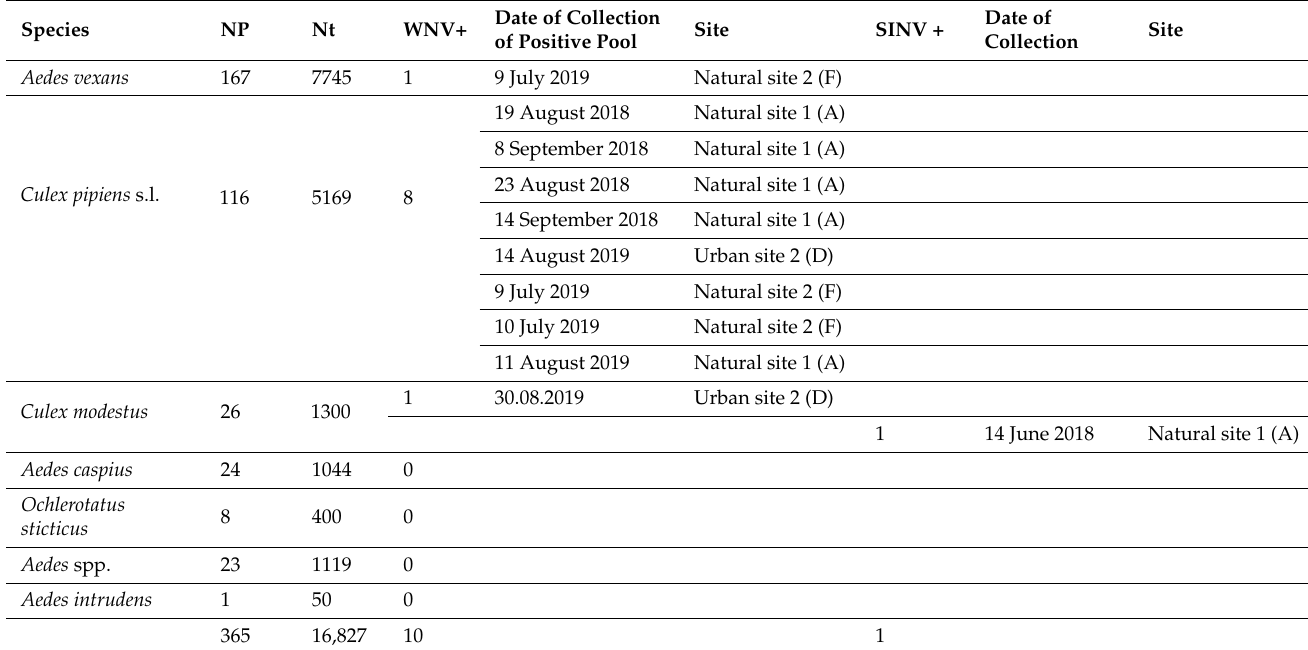
Figure 3. Mosquito screening results relative to the distribution of sampling sites in the two counties in eastern Romania. Purple circles represent urban sites, green circles represent the natural sites and the orange circle indicates the peri–urban sampling site. Natural site 1 = A, peri-urban site 1 = B, urban site 1 = C, urban site 2 = D, urban site 3 = E, natural site 2 = F, urban site 4 = G. Table 1. Virological findings in mosquitoes collected in Ia ș i and Tulcea counties, in 2018 and 2019. The number of tested mosquitoes (Nt) and tested pools (NP) and WNV and SINV positive pools are indicated.